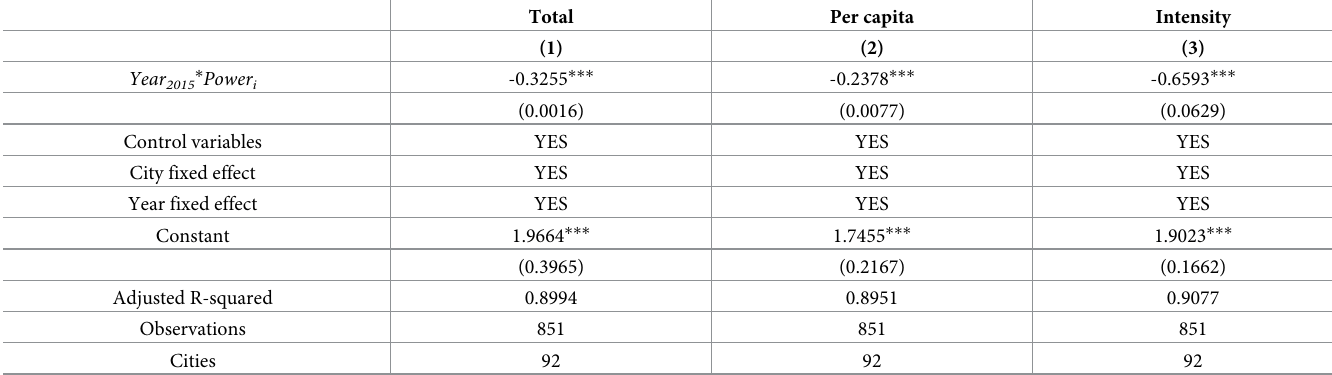
Table 10. Impact of power market reform on power